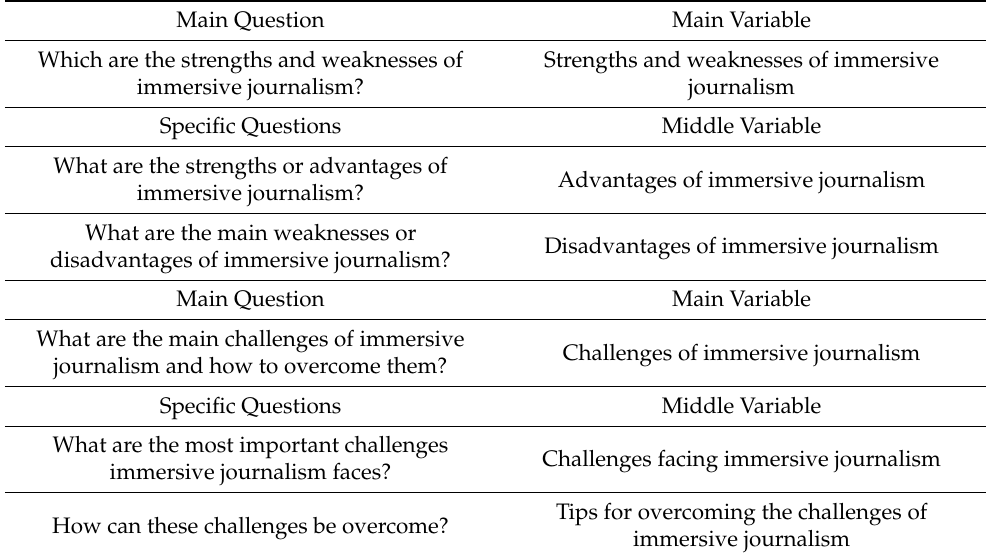
Table 1. Questions and variables used in the